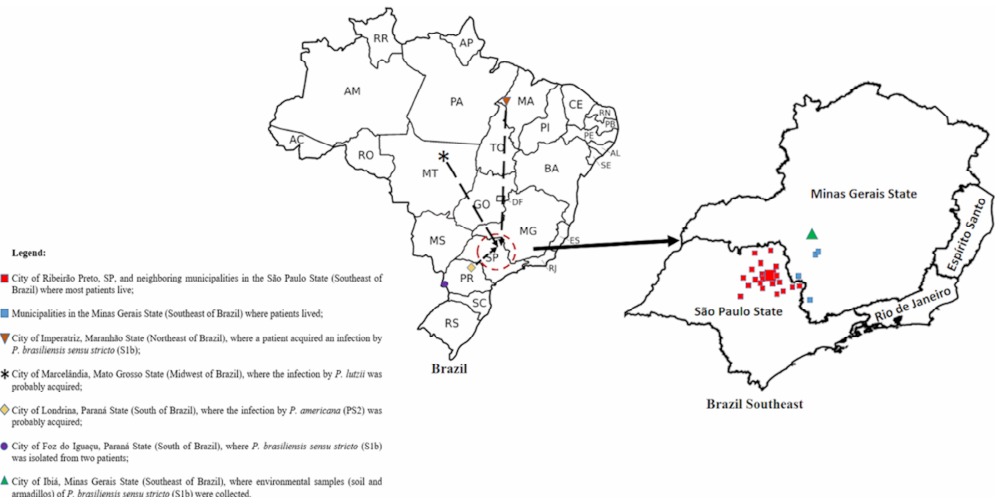
Figure 4. Map of Brazil highlighting the states of S ã o Paulo and Minas Gerais and showing the geographic area centered by Ribeir ã o Preto, SP ( ), where most patients lived; the migration of some patients who acquired the infection by Paracoccidioides spp. in other regions ( ); and the collection site of the environmental isolates (